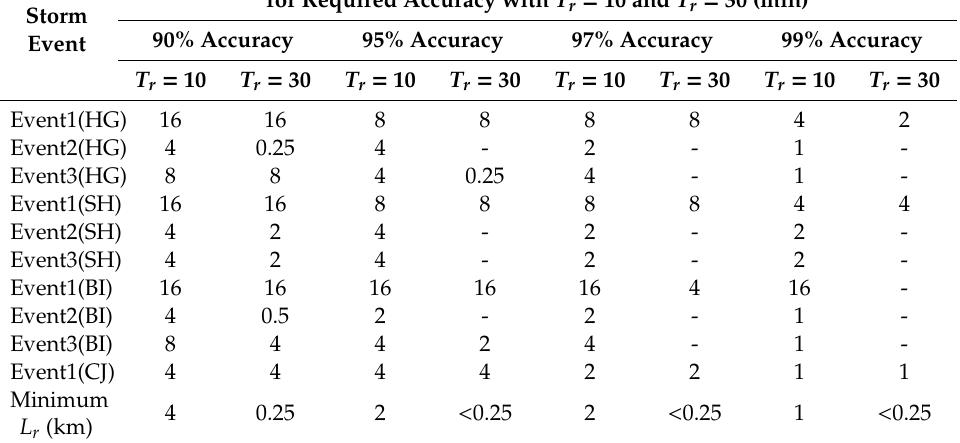
Upper limit of L r for the required peak discharge prediction accuracy for the Mihocheon watershed. Upper Limit of L r (km) for Required Accuracy with T r = 10 and T r = 30 (min) Storm 90% Accuracy 95% Event